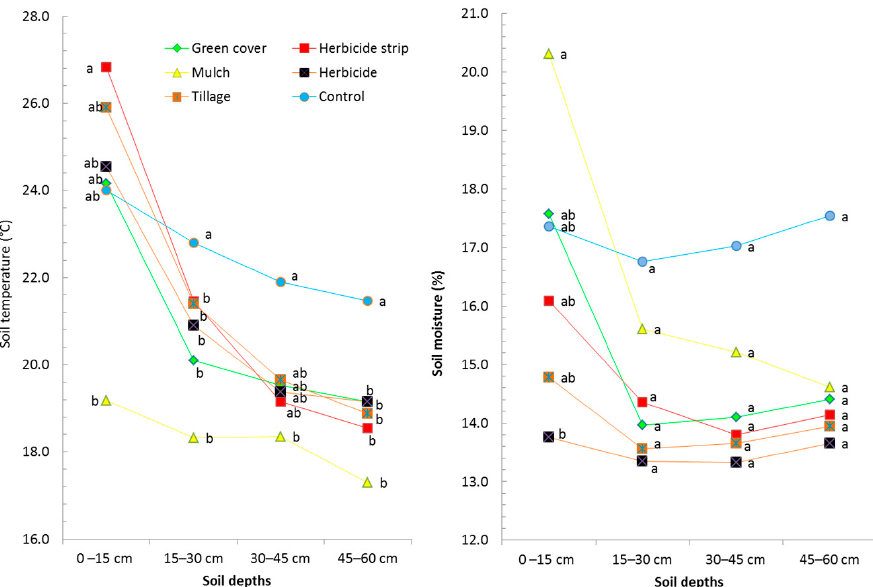
Figure 7. Mean soil temperature and moisture of spring samples in the third year of the trial along with the soil profile at depths from 0 to 60 cm. according to different soil management practices. Different letters denote significant differences among soil management practices in each depth ( p ≤ 0.05).